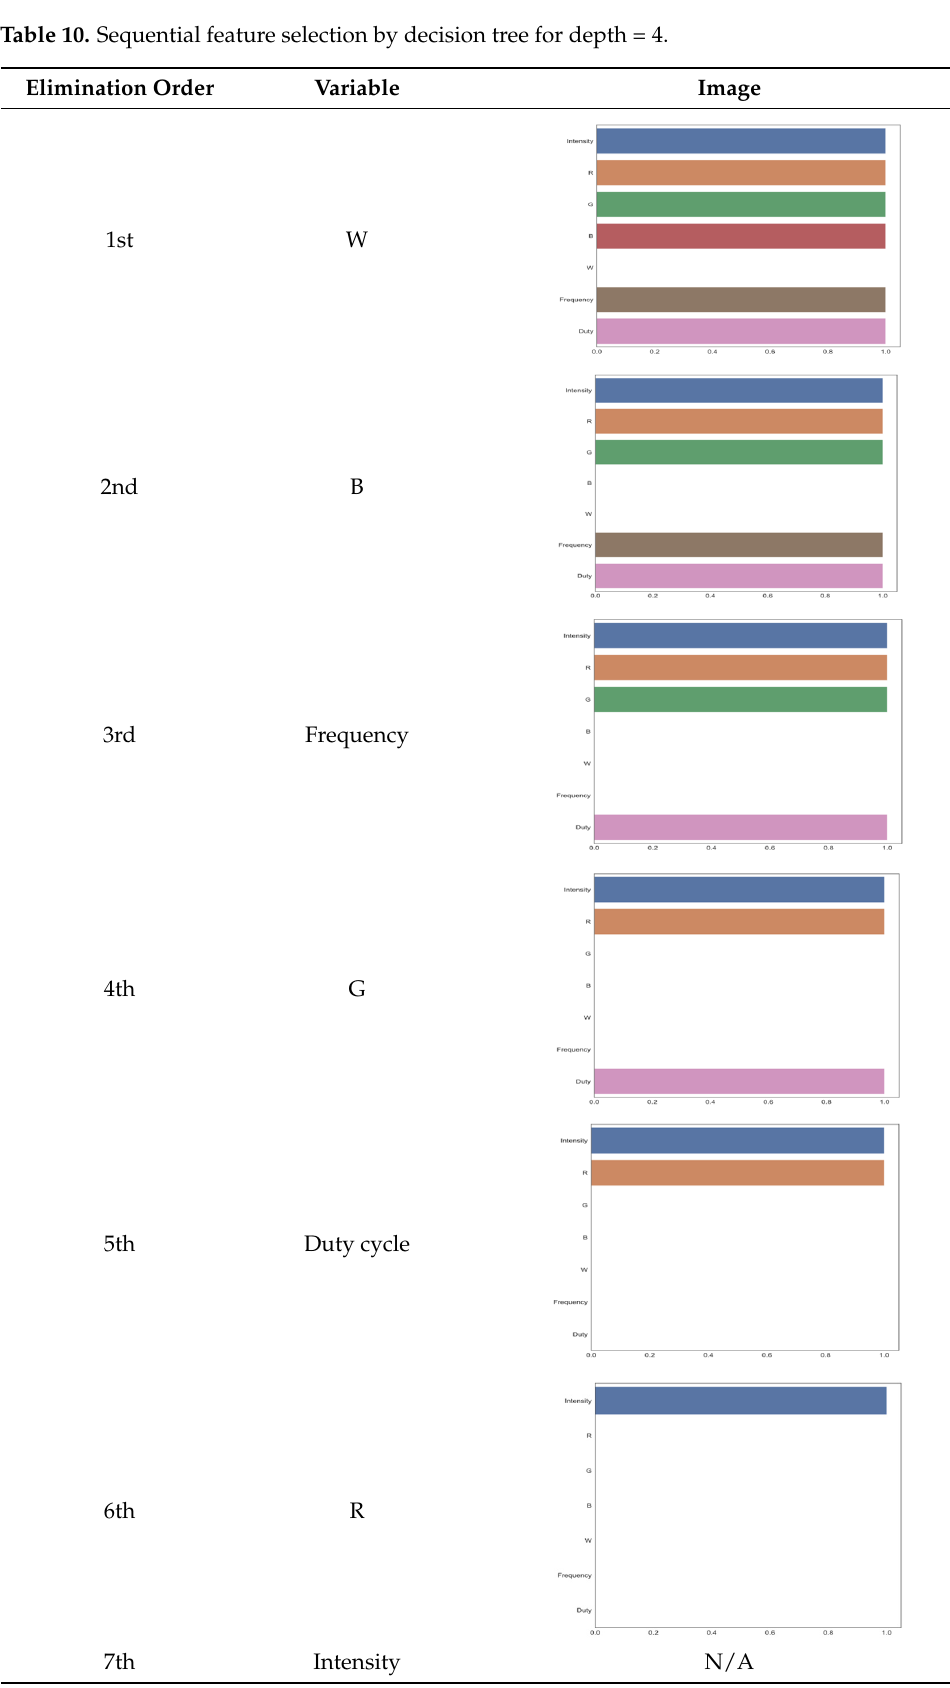
Table 10. Sequential feature selection by decision tree for depth = 4.